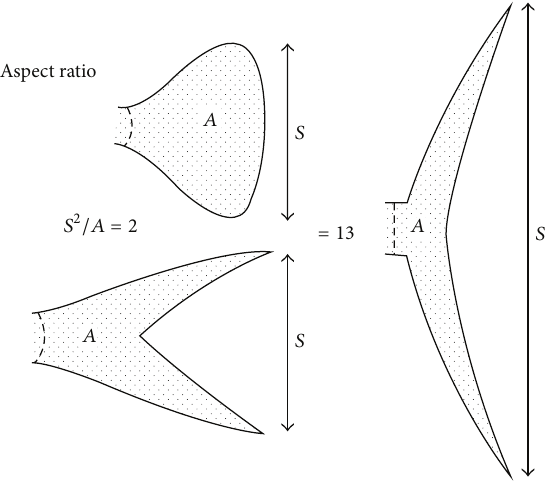
Figure 1: Caudal fin shapes